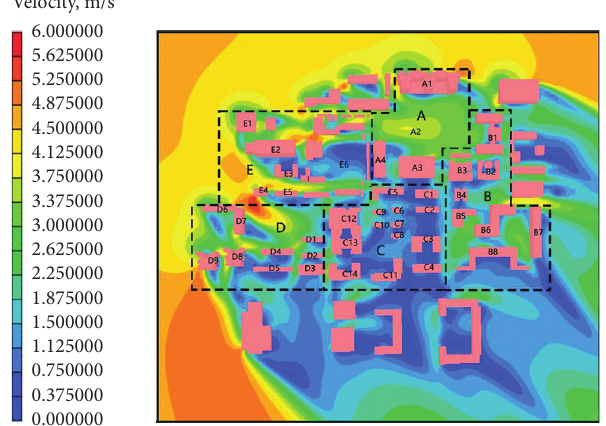
Figure 12: The wind velocity contour map at Z � 1.5m in